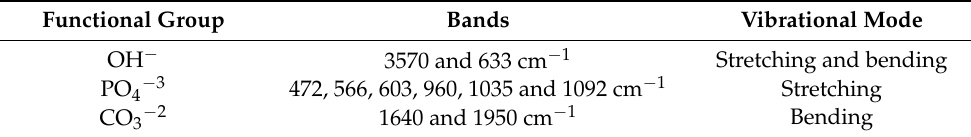
Table 6. Functional groups, FTIR bands, and vibrational modes identified in the HAp samples.